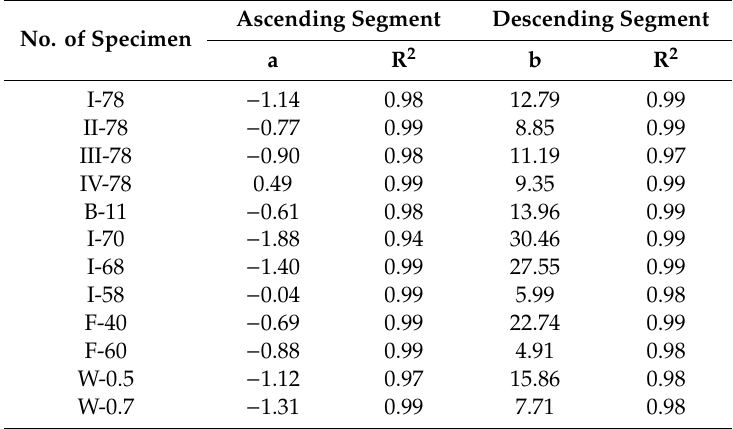
Table 5. Fitting parameters of the stress–strain curve for di ff erent